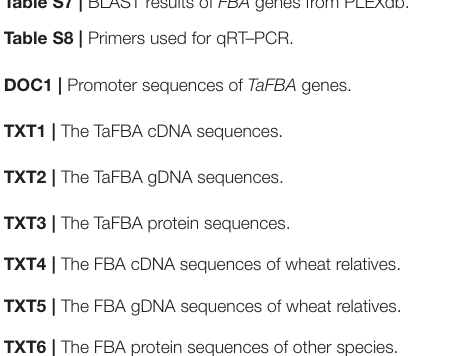
Table S6 | Annotation of cis-regulatory elements involved in phytohormone and abiotic stress response of plants. Table S7 | BLAST results of FBA genes from PLEXdb. Table S8 | Primers used for